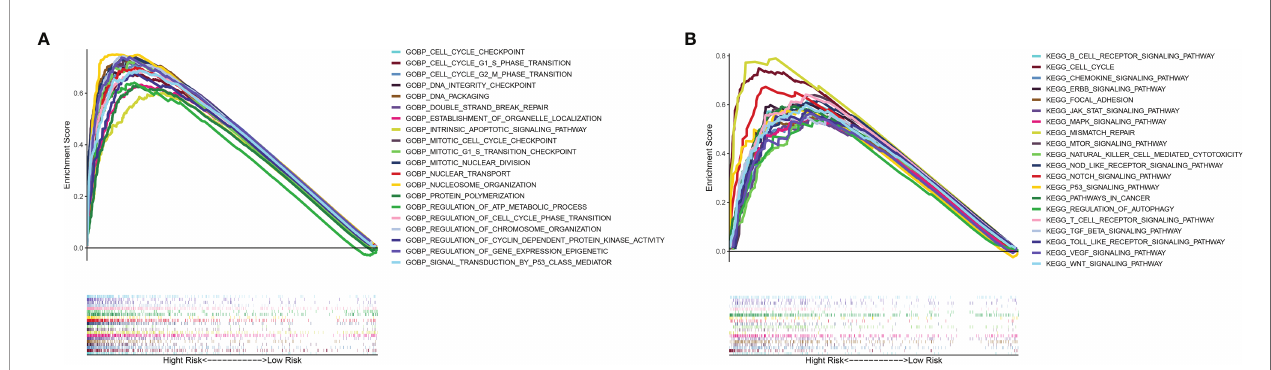
FIGURE 7 | GSEA of biological functions and pathways. (A) Gene Ontology. (B) Kyoto Encyclopedia of Genes and